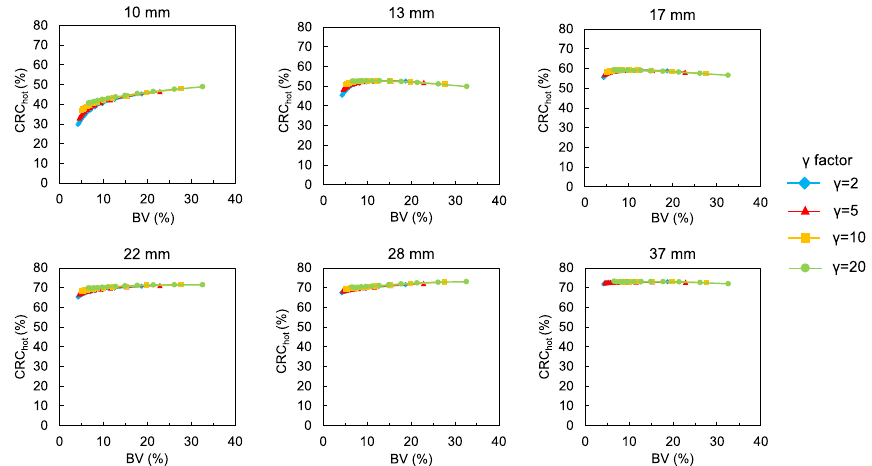
Fig. 4 Relationship between CRC hot and BV curves of hot spheres with diameters of 10, 13, 17, 22, 28 and 37 mm using BPL reconstructions with different γ factors. Curves for BPL run from left to right as β values